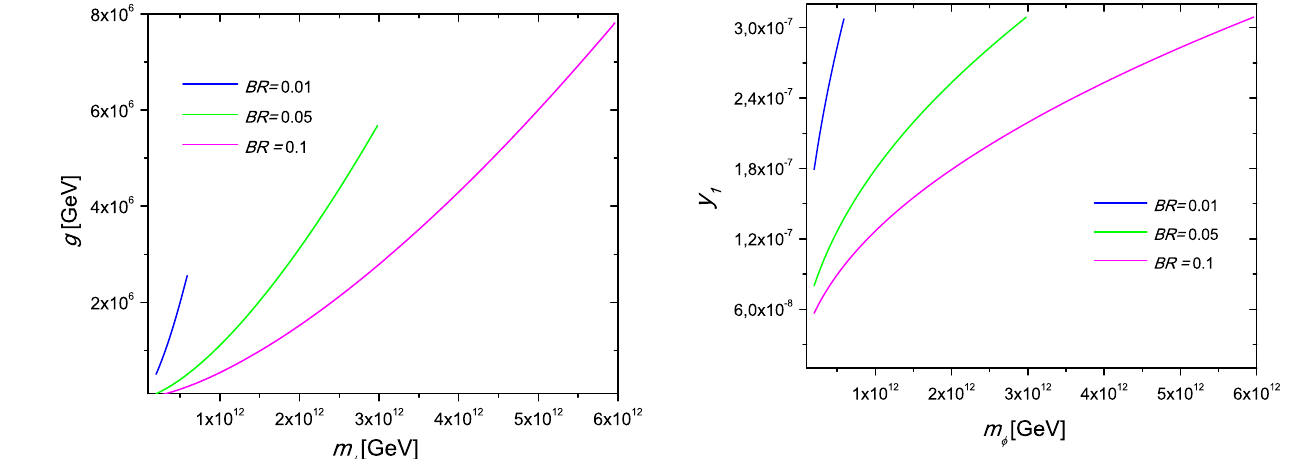
Fig. 1 Triscalar coupling constant g versus the inflaton mass m φ (both in GeV) for three different values of the branching ratio, 0.01 (blue), 0.05 (green) and 0.1 (magenta)